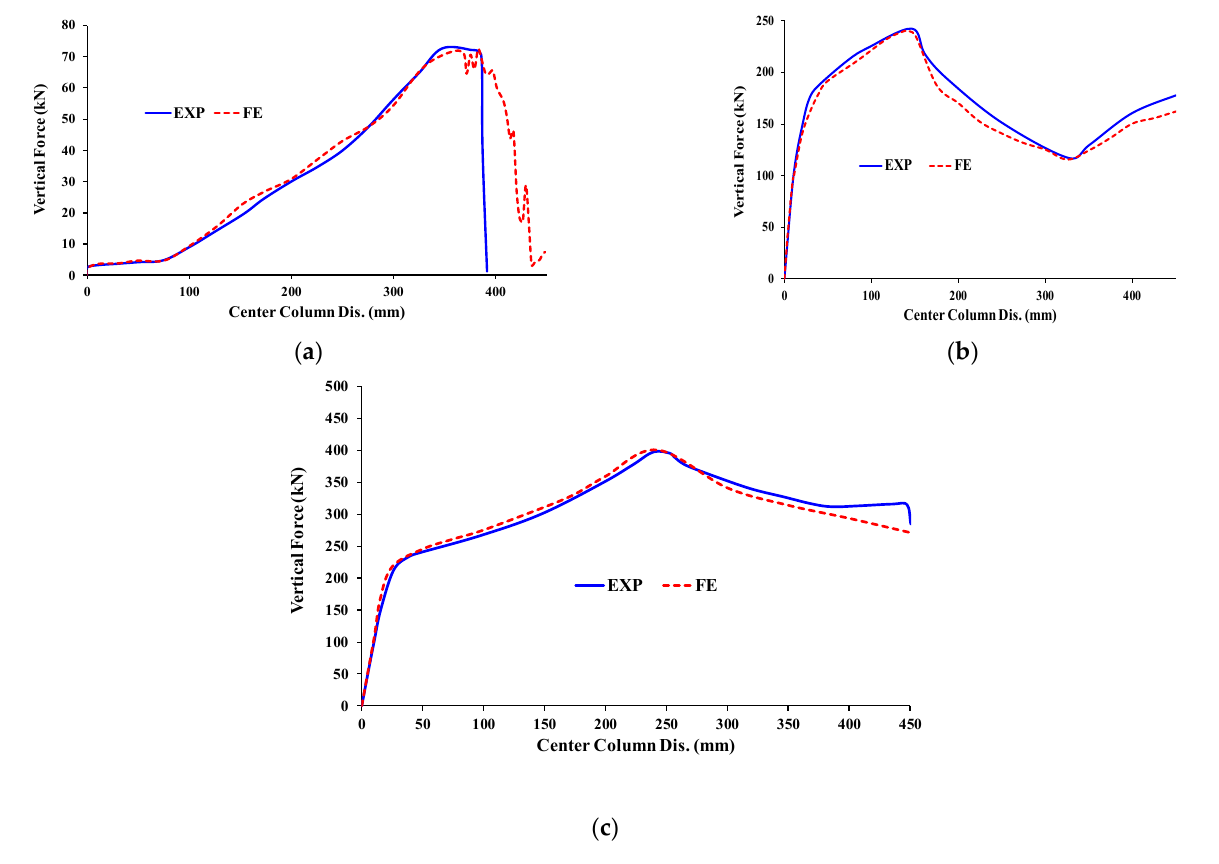
Figure 11. Curves of force and center column displacement comparison of experimental and FE for: ( a ) J-S-C; ( b ) J-M-C; ( c ) J-S-S-EX [29].